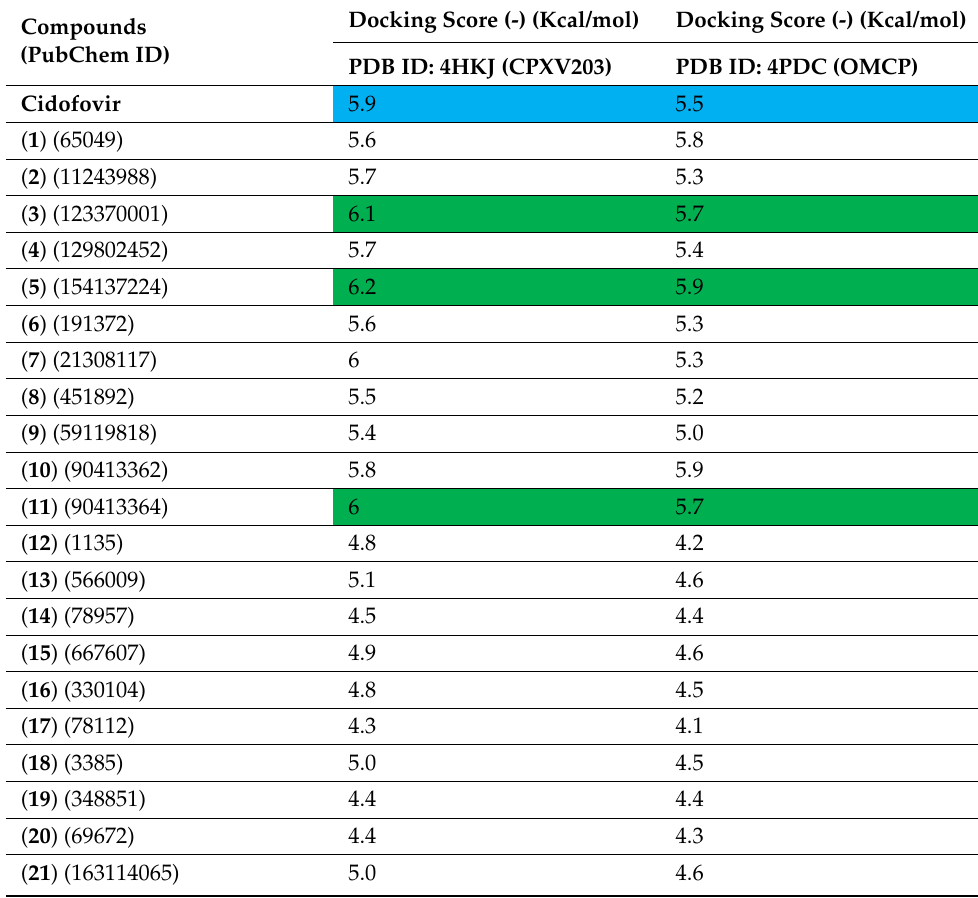
Table 1. The molecular docking analysis of twenty-one structures on two different cowpox proteins compared to cidofovir as the standard (shown in blue) and the best lead structures (shown in green).